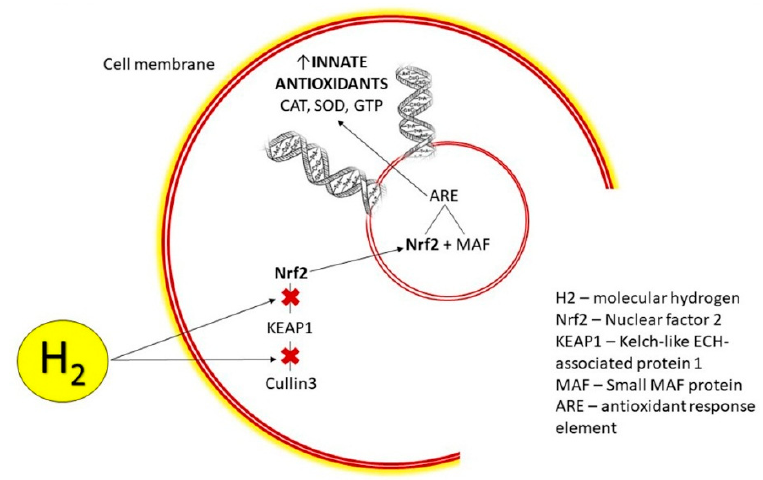
Figure 2. Mechanism of H 2 action: transcription and production of innate antioxidants upon entry into cell cytoplasm, release and accumulation of Nrf2 and its translocation into the nucleus. CAT = catalase, SOD = superoxide dismutase, GTP = glutathione peroxidase .